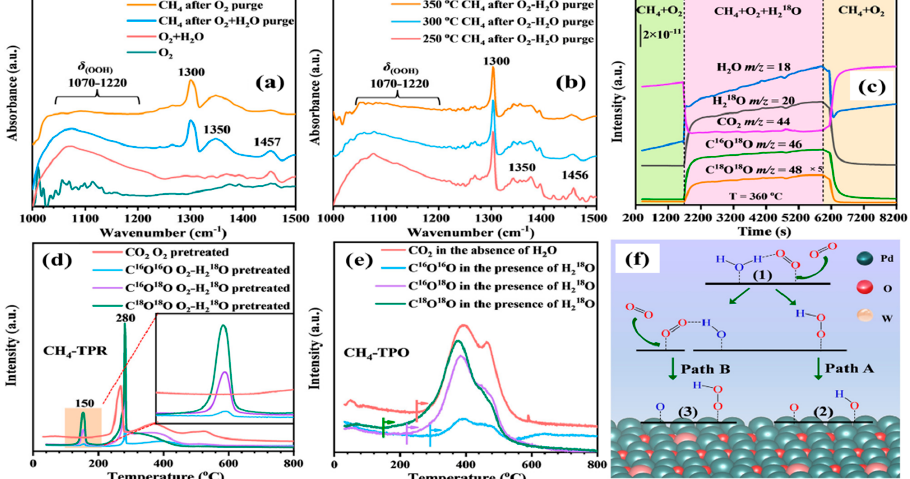
Figure 14. In situ DRIFTS spectra over PdW 1 /Al 2 O 3 ( a ) under different gas conditions at 250 °C and ( b ) at different temperatures under CH4 after H 2 O-O 2 purge; ( c ) products profiles of CH 4 -TPSR over PdW 1 /Al 2 O 3 at 360 °C in the experiment of isotopic water introduction and cut-off with a reaction gas feed; ( d ) CO 2 profiles in CH 4 -TPR isotopic trace experiment over PdW 1 /Al 2 O 3 after O 2 or O 2 - H 218 O pretreatment; ( e ) CO 2 profiles in CH 4 -TPO isotopic trace experiment; and ( f ) reaction scheme for O 2 activation in the presence of H 2 O (the blue color means the element from H 2 O, whereas the red color means the element from oxygen). Reprinted with permission from Ref. [108]. Copyright 2022, copyright John Wiley and Sons.